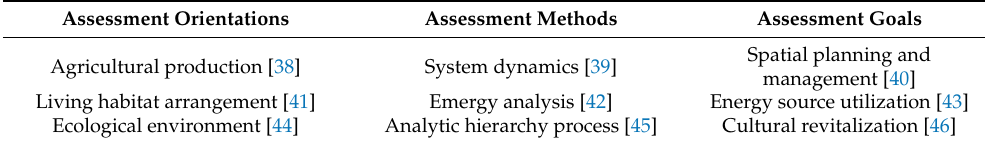
Table 1. Existing methods for sustainability assessments with evaluation indicator